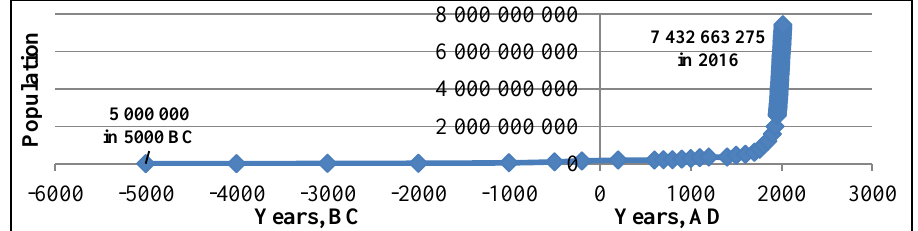
Fig. 1. The increase of world population from 5000 BC to 200 BC and from 200 AD to 2016 AD (Worldometers, 2016; United States Census Bureau, 2016; United Nations Population Division, 2001) (Figure created by